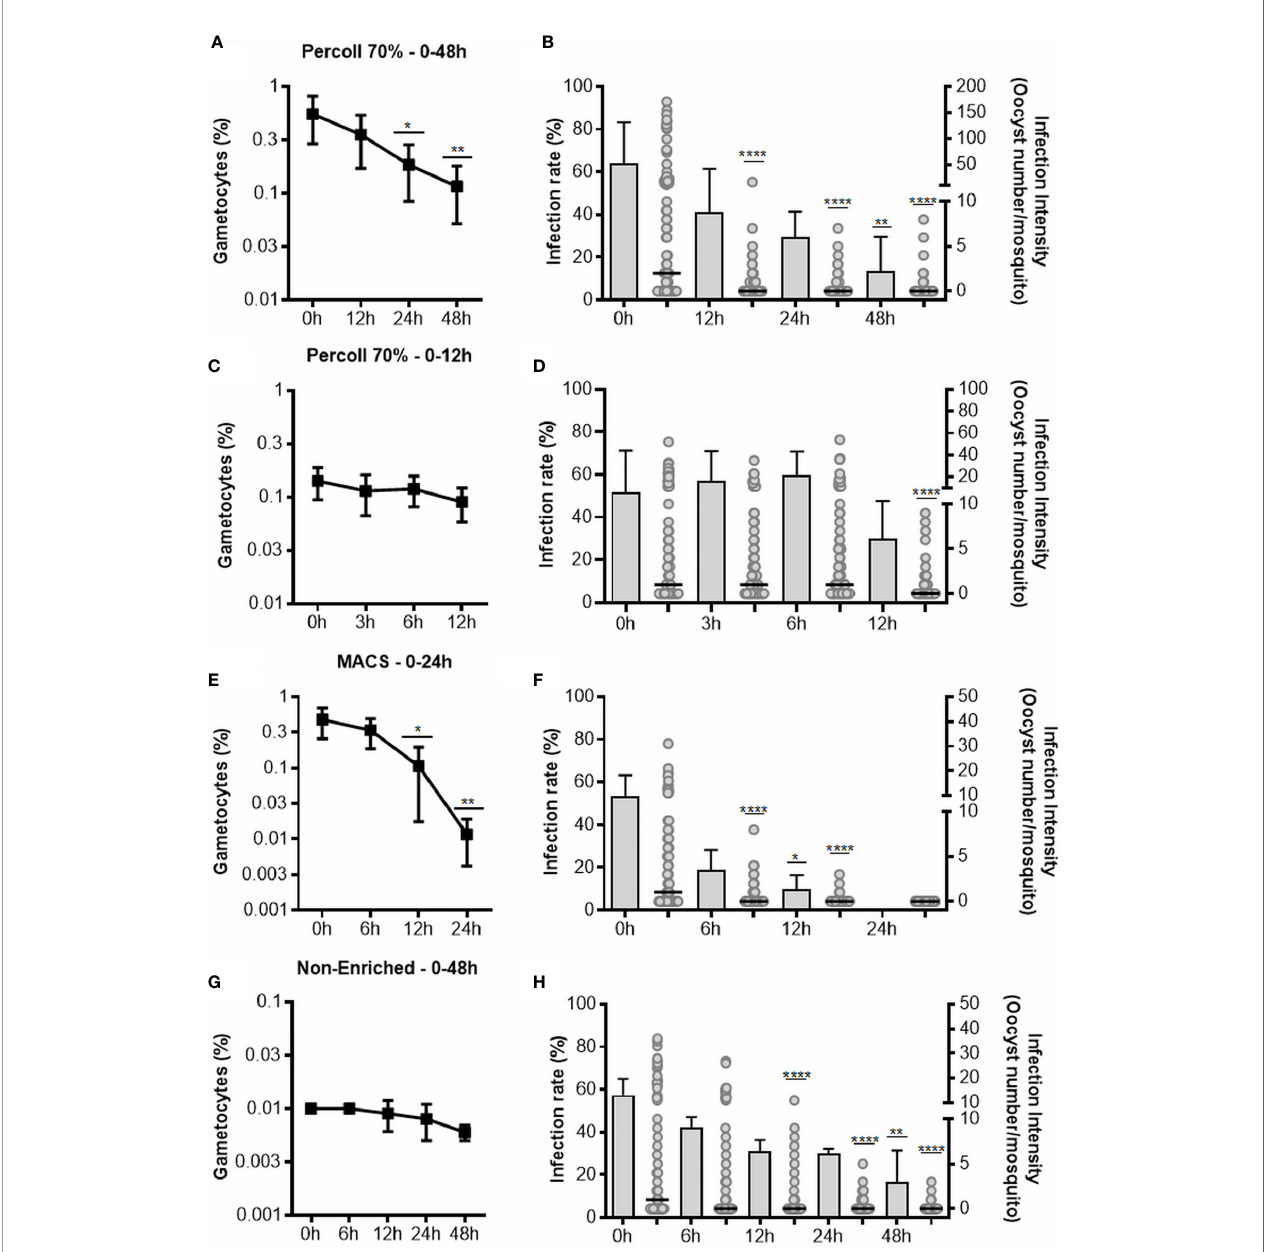
FIGURE 1 | Gametocyte viability and infectivity in cultures enriched by Percoll after 48 (A, B) and 12 h (C, D) , enriched by MACS (E, F) and non-enriched (G, H) . The line graph in (A, C, E, G) represents the gametocytes in thin smears of culture stained with Giemsa. Each point represents the average of viable gametocytes counted for each interval, and vertical lines represent the standard error. Graphs (B, D, F, H) represent the infectivity. The infection rate is presented in bars as the mean and standard deviation, and the intensity of the infection is represented as the number of oocysts per single midgut (dots) with medians (horizontal black lines). Results shown for Percoll 48 h (n = 6), Percoll 12 h (n = 6), MACS (n = 6) and non-enriched (n = 5) are from independent experiments. Asterisks (*), (**), (****) represent signi fi cant differences (p <0.05, p <0.01 and p <0.0001, respectively) in relation to 0